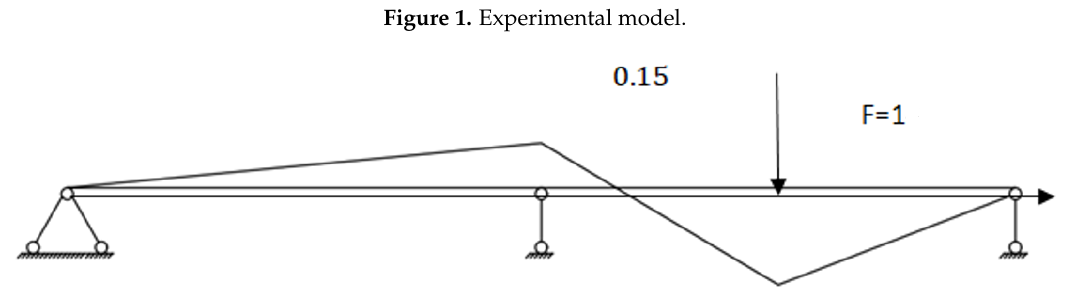
Figure 2. Figure M .